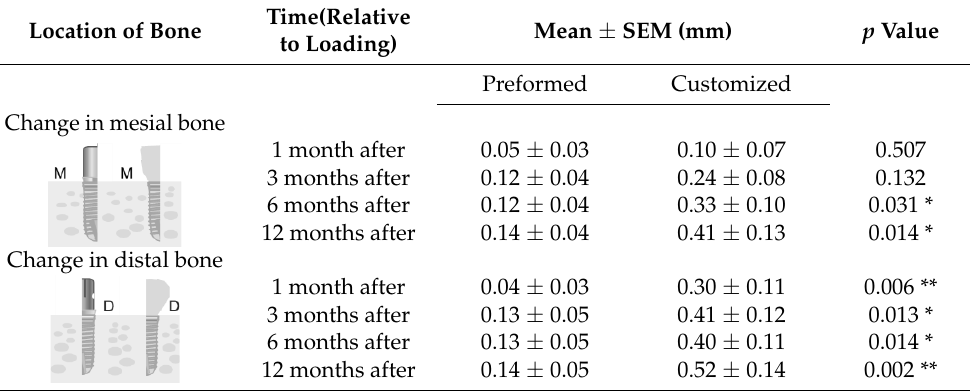
When comparing the average of the surrounding implant crestal bone level, no sig- nificant difference was found between the PA group and the CA group, as shown in the table. No significant difference was noted in the radiographs of the PA group and CA